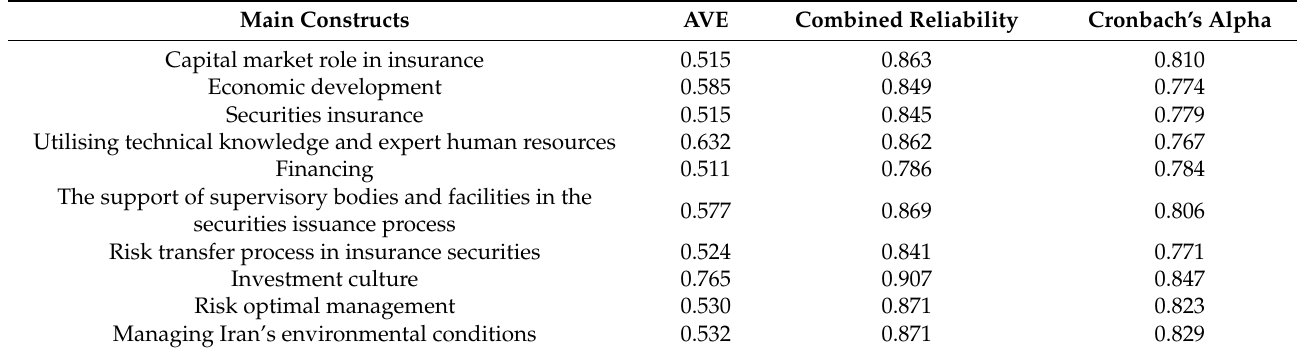
Table 3. The external validity of research